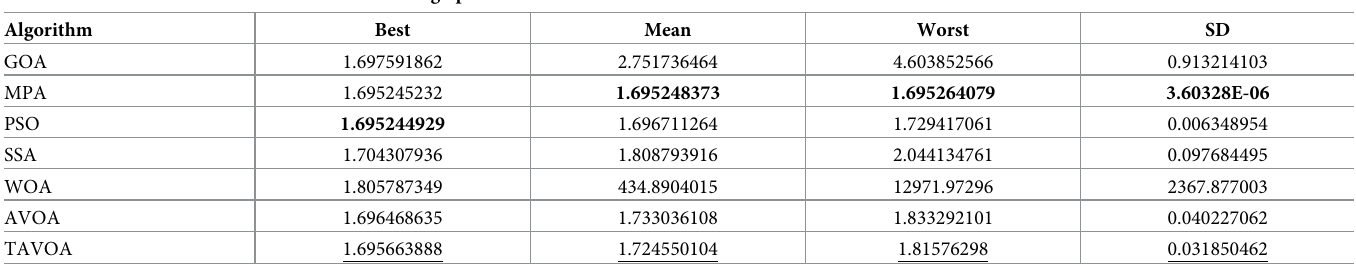
Table 12. Statistical results of the welded beam design problem. Algorithm